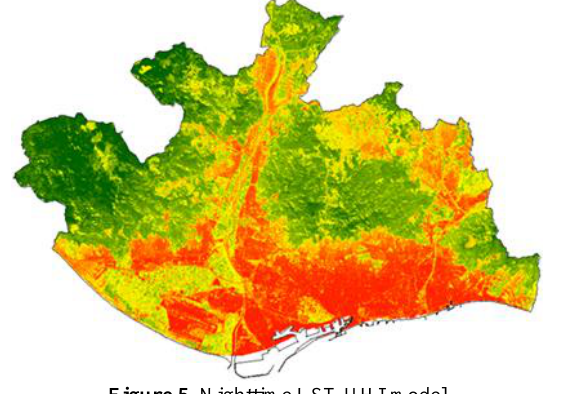
Figure 5 . Nighttime LST-UHI model